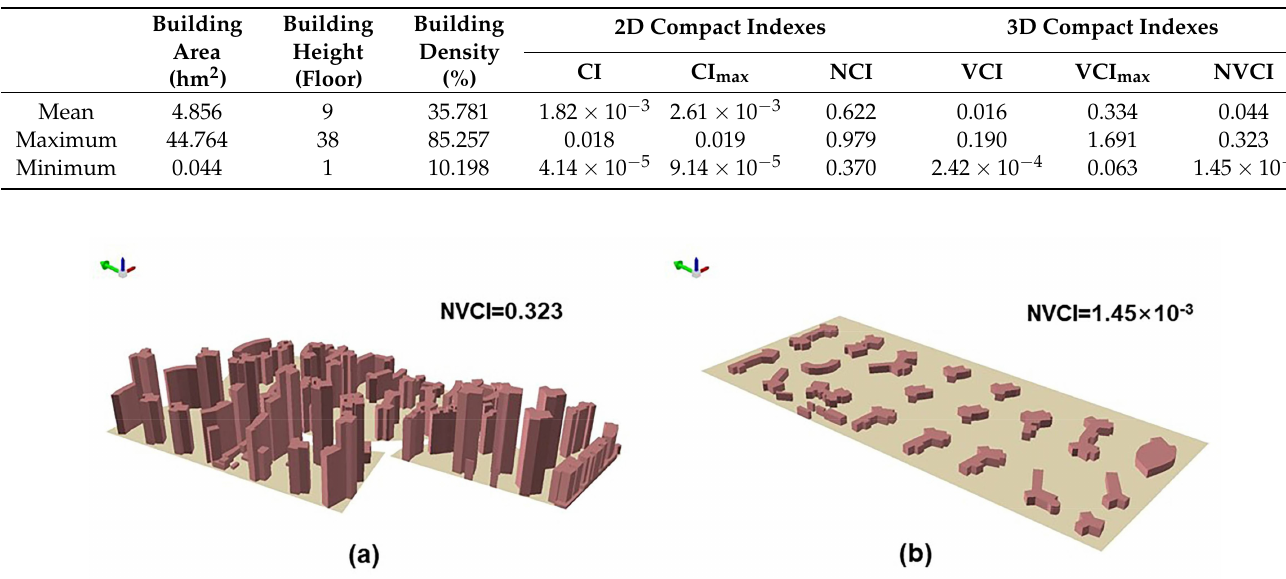
Figure 8. ( a ) The building heights in communities with the maximum NVCI; ( b ) The building heights in communities with the minimum NVCI.